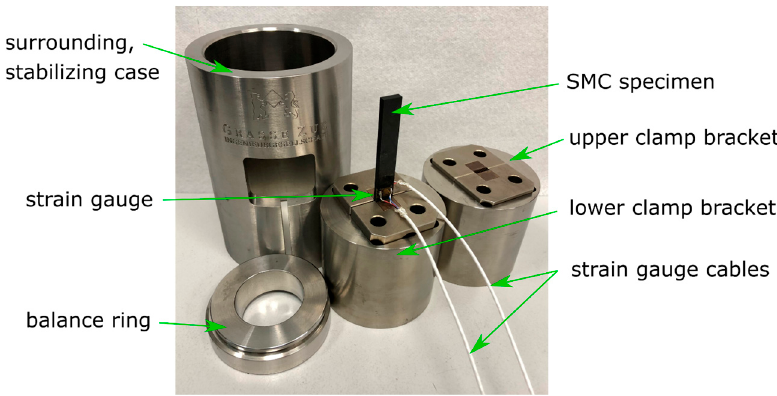
Figure 8. Compression creep test fixture build apart.